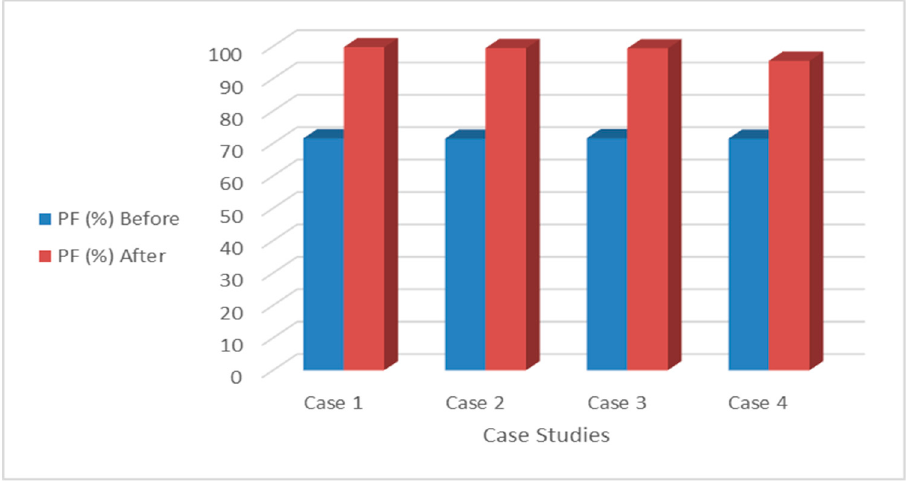
Figure 5. PF improvement across all case studies.